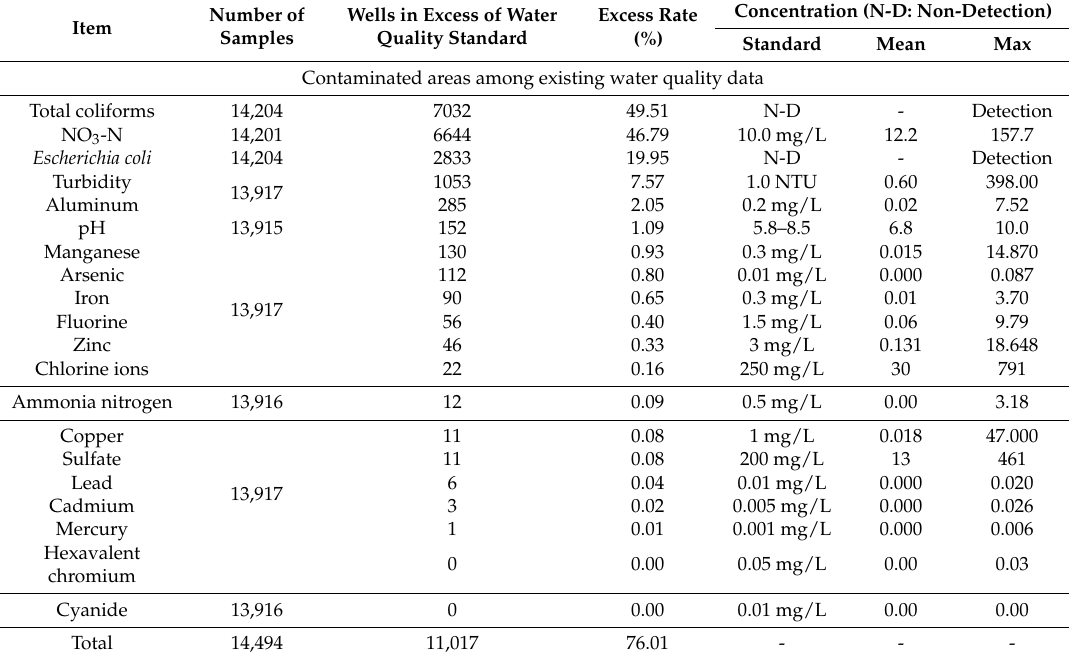
Table 7. Results of water quality analysis with 20 items for the total number of wells in